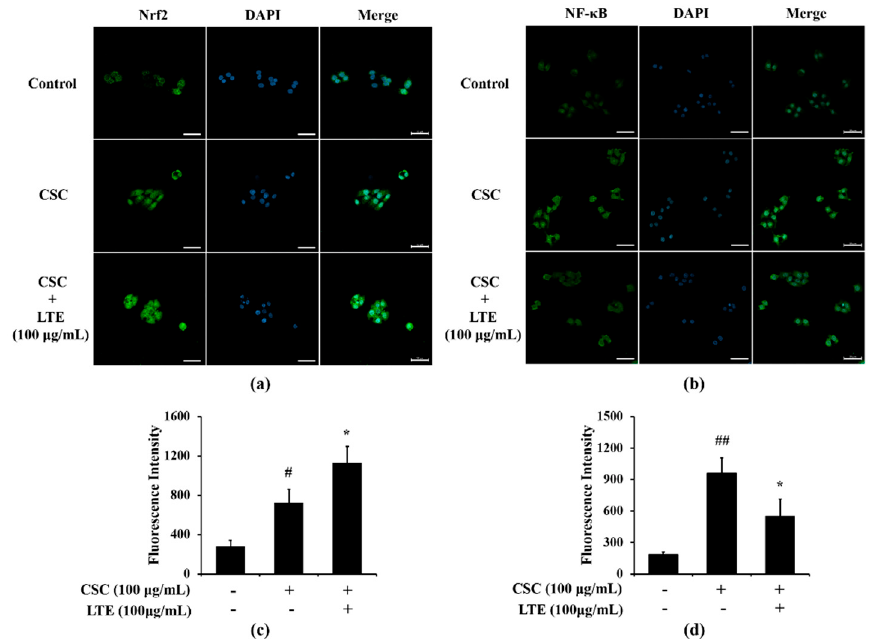
Figure 6. Effects of LTE on Nrf2 and NF- κ B expression in CSC stimulated H292 cells. ( a ) representative figure for Nrf2, ( b ) representative figure for NF- κ B, ( c ) quantitative analysis of Nrf2 expression, ( d ) quantitative analysis of NF- κ B. The treatment of LTE increased Nrf2 translocation into the nucleus but decreased NF- κ B translocation into the nucleus in CSC stimulated H292 cells. This experiment was performed in triplicate. Scale bar = 50 μ m. Data shown as the mean ± SD. # , ## , vs. Control, p < 0.05 and <0.01, respectively, *, vs. CSC-treated cells, p < 0.05.